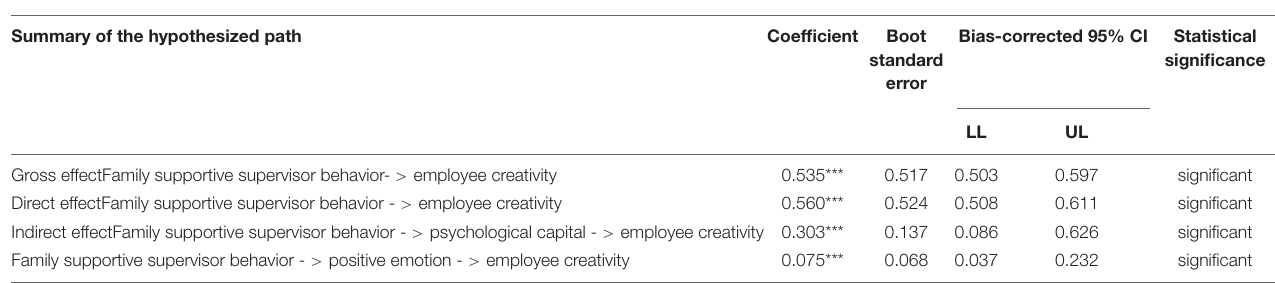
TABLE 6 | Bootstrapping mediation effects